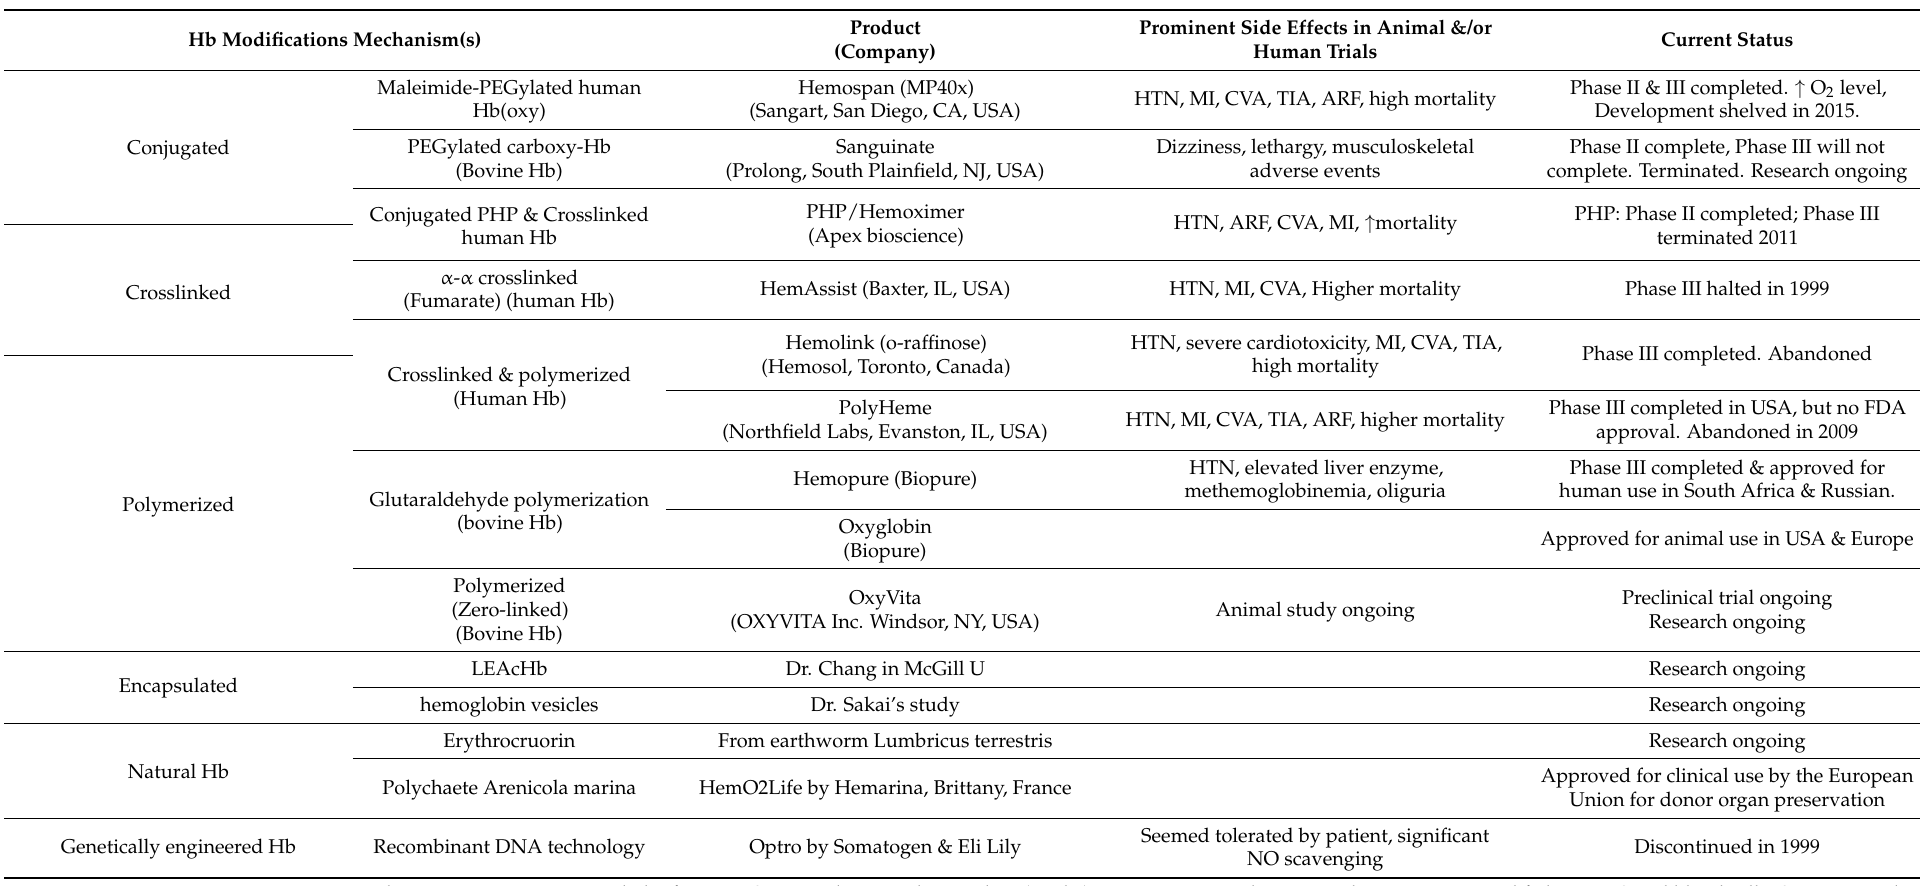
Table 1. Hemoglobin-based oxygen carriers: a summary of HBOC